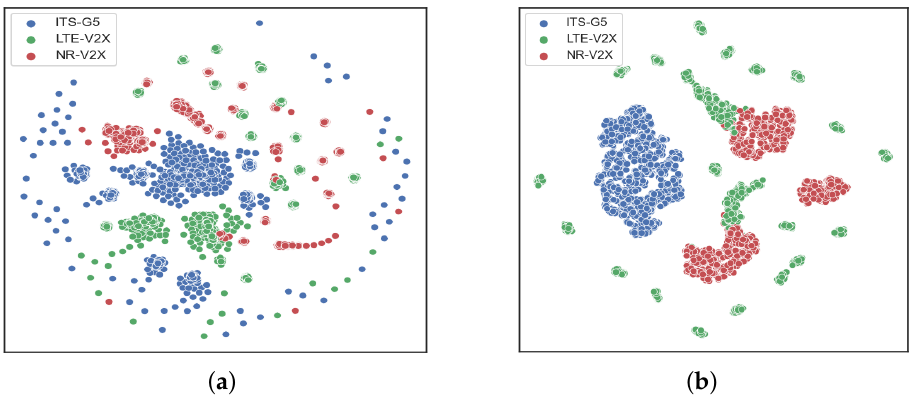
Figure 3. t-sne representation of ( a ) SCF and ( b ) IF